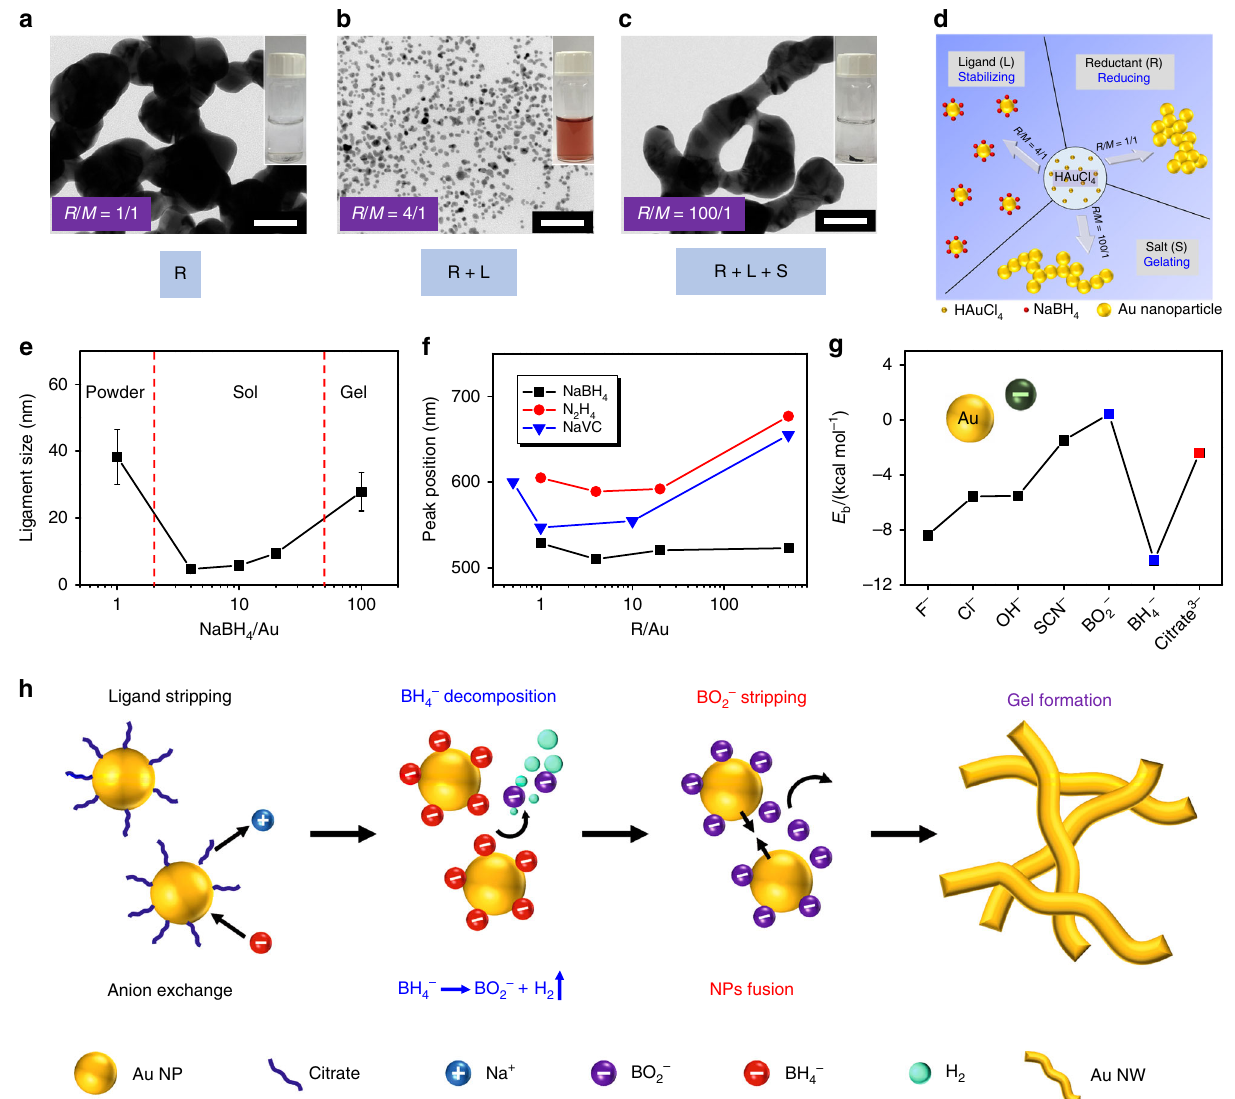
Fig. 2 Analysis of the multiple-roles played by the reductant. a – c TEM images and photographs (insets) of the resulting gold materials for NaBH 4 /gold ratios of 1/1, 4/1, and 100/1, and d the function(s) of NaBH 4 exhibited in the respective systems. e The ligament size of the gold gels vs. the NaBH 4 /gold ratio (error bars depict the standard deviation). f The peak position at maximum absorption (from UV-vis absorption spectra) vs. the reductant/gold ratio for different reductants. g Theoretically calculated binding energies between the gold atom and various anions. h The proposed mechanisms for the excessive NaBH 4 -directed gelation process. The scale bars are 50 nm in a – c